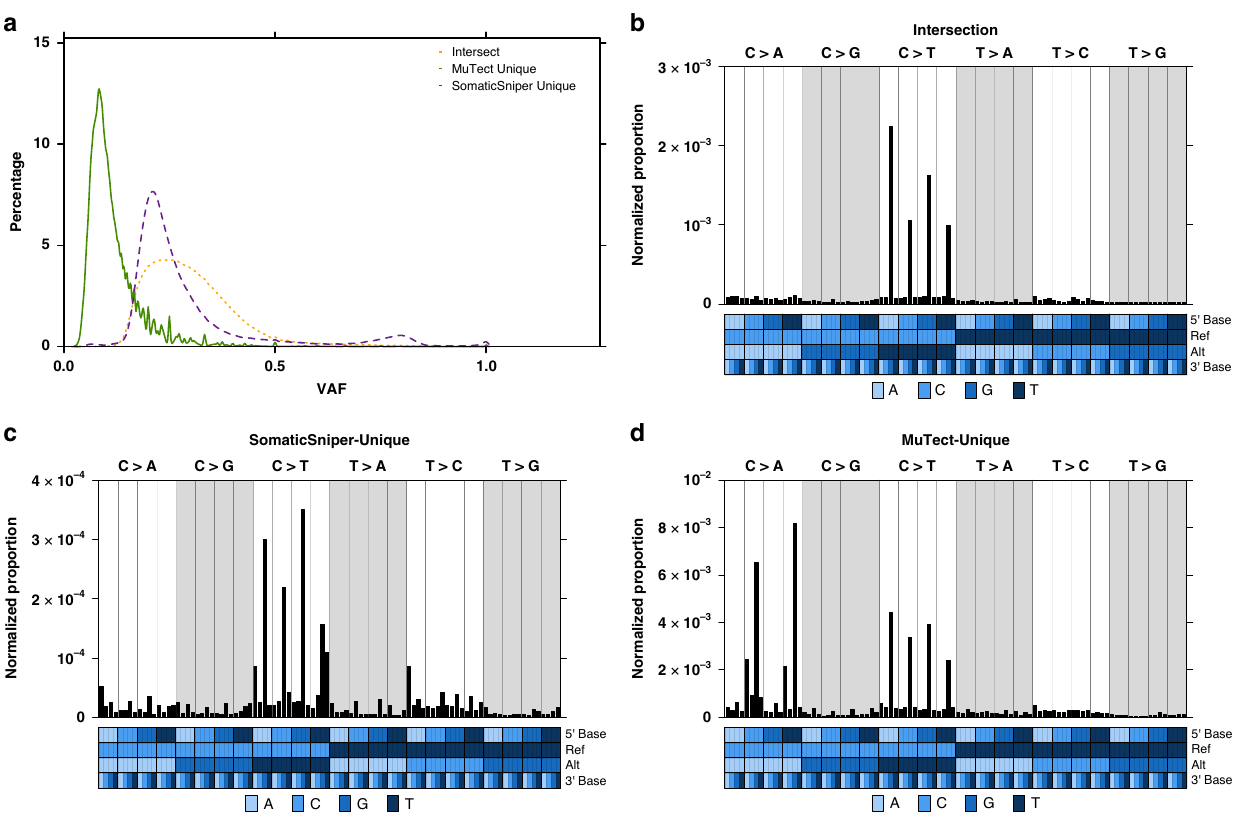
Fig. 4 Tool-speci fi c error pro fi les in SNV detection. a Density plots of variant allele frequencies for SNVs across all samples that were detected by both SomaticSniper and MuTect (Intersect, short dash orange line), only detected by MuTect (MuTect Unique, solid green line) and only detected by SomaticSniper (SomaticSniper Unique, long dash purple line). VAF, variant allele frequency. b Trinucleotide pro fi le of SNVs that were detected by both SomaticSniper and MuTect, where the number of SNVs was normalized by the expected number of each trinucleotide context across the hg19 genome. Trinucleotide pro fi les for c SNVs only detected by SomaticSniper and d SNVs only detected by MuTect. Colors in the covariate bar indicate the 5 ’ , reference, alternative and 3 ’ nucleotides in each trinucleotide context. Ref, reference nucleotide; Alt, alternative nucleotide of variant; SNV, single nucleotide variant. Number of SNVs across all samples in Intersect: n = 453,855 independent observations; SomaticSniper Unique n = 198,623; MuTect Unique n = 2,801,546. Consistency of mutation clonality prediction . One goal of subclonal reconstruction is to time when individual mutations occurred during tumour evolution. We therefore compared clonal and subclonal SNV identi fi cation for the same set of 293 WGS samples across sixteen pipelines for subclonal reconstruction. As expected from the different types of SNVs leveraged for subclonal reconstruction, algorithms were highly discordant in the numbers of SNVs identi fi ed as clonal or subclonal. In samples where the subclonal reconstruction algorithm was successfully executed across all four mutation detection tool combinations, DPClust used and timed the most SNVs on average (2941 ± 3929, mean ± SD; Fig. 5a), followed by PhyloWGS (2473 ± 1662, Fig. 5b), PyClone (1738 ± 1580, Fig. 5c) and SciClone (178 ± 480, Fig. 5d). As expected from the in fl uence of MuTect on the prediction of subclonal clusters, its use was associated with the identi fi cation of an order of magnitude more subclonal SNVs, but similar num- bers of clonal SNVs as with use of SomaticSniper. To further evaluate how mutation detection tools affect the timing of SNVs, we calculated the Jaccard index of clonal SNVs identi fi ed between all pipeline pairs using the same subclonal reconstruction algorithm, and the same for subclonal SNVs (Fig. 5e). In PhyloWGS-comprising pipelines, clonal SNV identi fi cations were in high agreement (mean Jaccard index ± SD: 44.6 ± 30.2%) but subclonal SNV identi fi cations were signi fi cantly less so (10.0 ± 22.4%; p < 2.2 × 10 − 16 , Wilcoxon NATURE COMMUNICATIONS| (2020) 11:6247